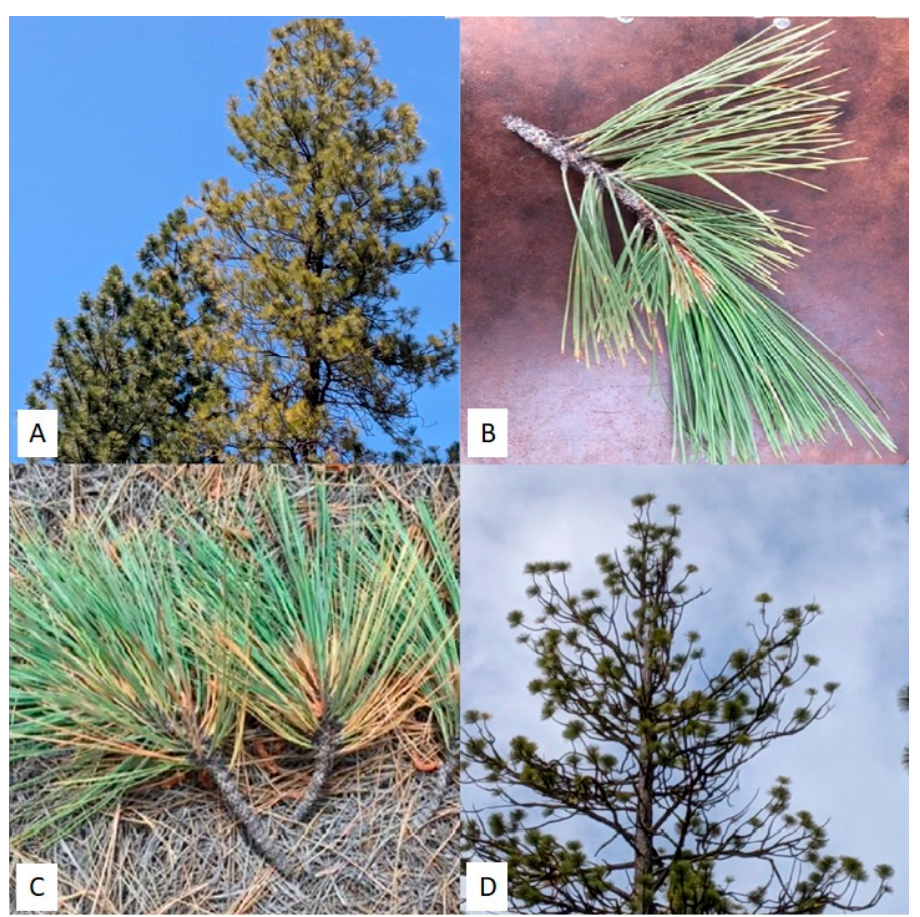
Figure 2. Examples of qualitative visual characteristics used to assess trees to vigor classes. ( A ) The tree on the right exhibits chlorosis and low needle retention, while the tree on the left has good needle color and mass, ( B ) reduced needle elongation and fading, ( C ) needle senescence, and ( D ) low needle retention (from [32]). Table 2. Whole-tree and branch characteristics used in assigning qualitative-vigor classes to pon- derosa pine individual tree crowns (ITCs). DMR is the dwarf mistletoe rating.